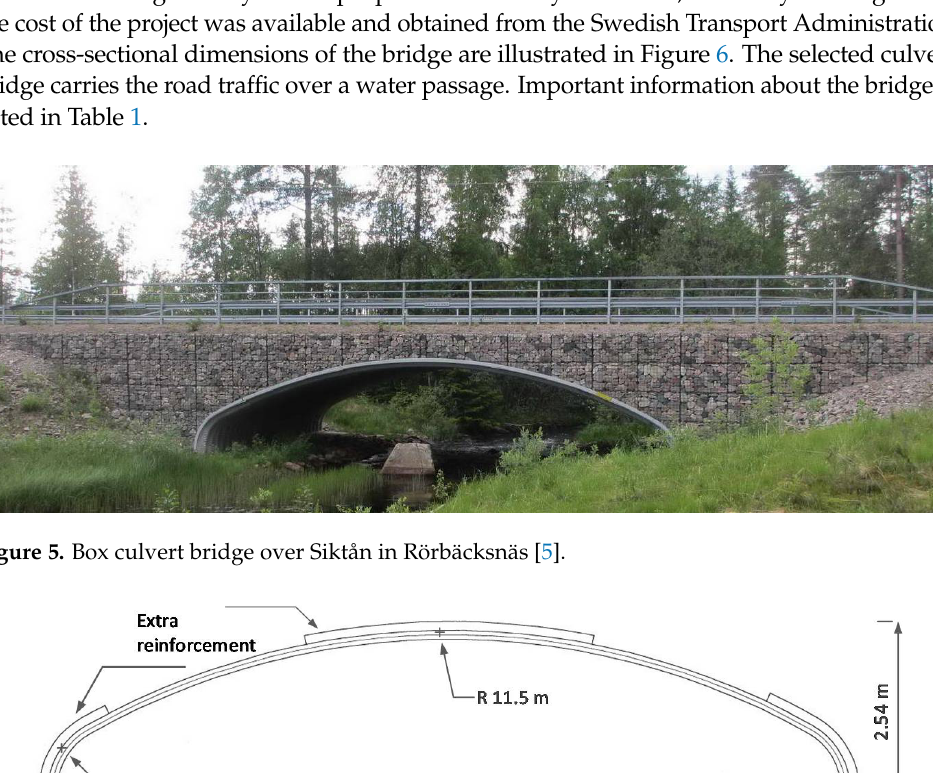
Table 1. General information about the selected case study bridge [5].